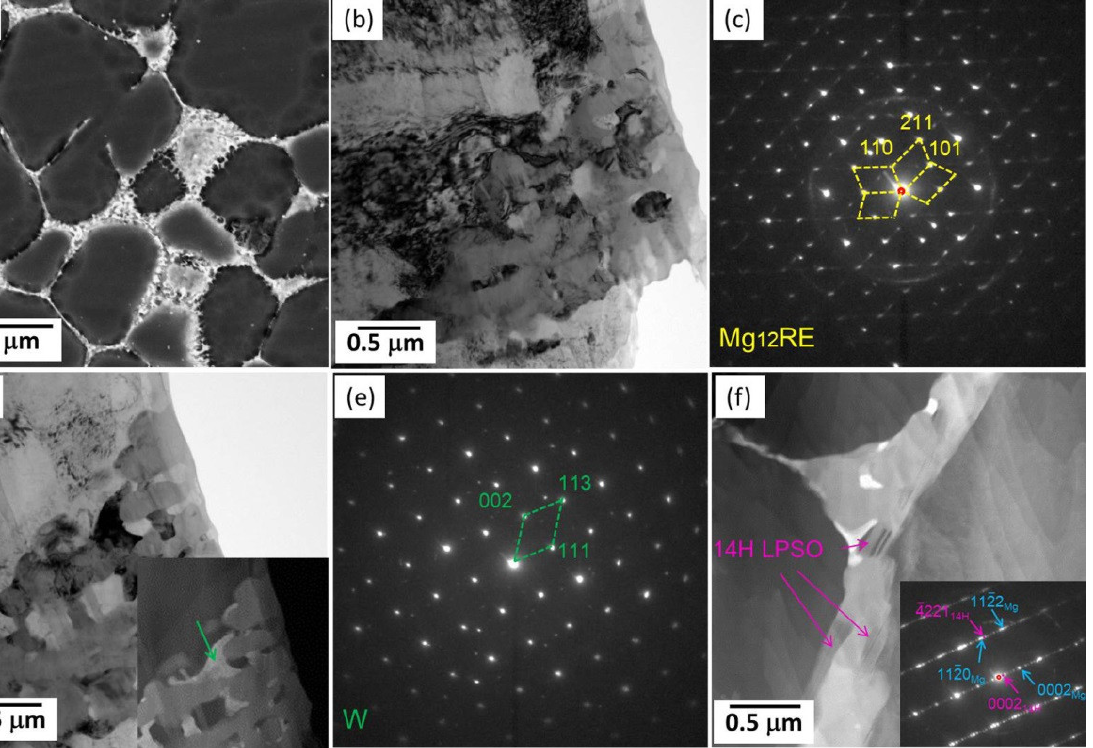
Figure 12. ( a ) SEM image of the HPDC ZLaW423 alloy, ( b , d ) TEM images along with ( c , e ) the corresponding SAED patterns of the dominant intermetallic phases, and ( f ) HAADF-STEM image showing LPSO plates with the corresponding SAED paern shown in the insert [46].